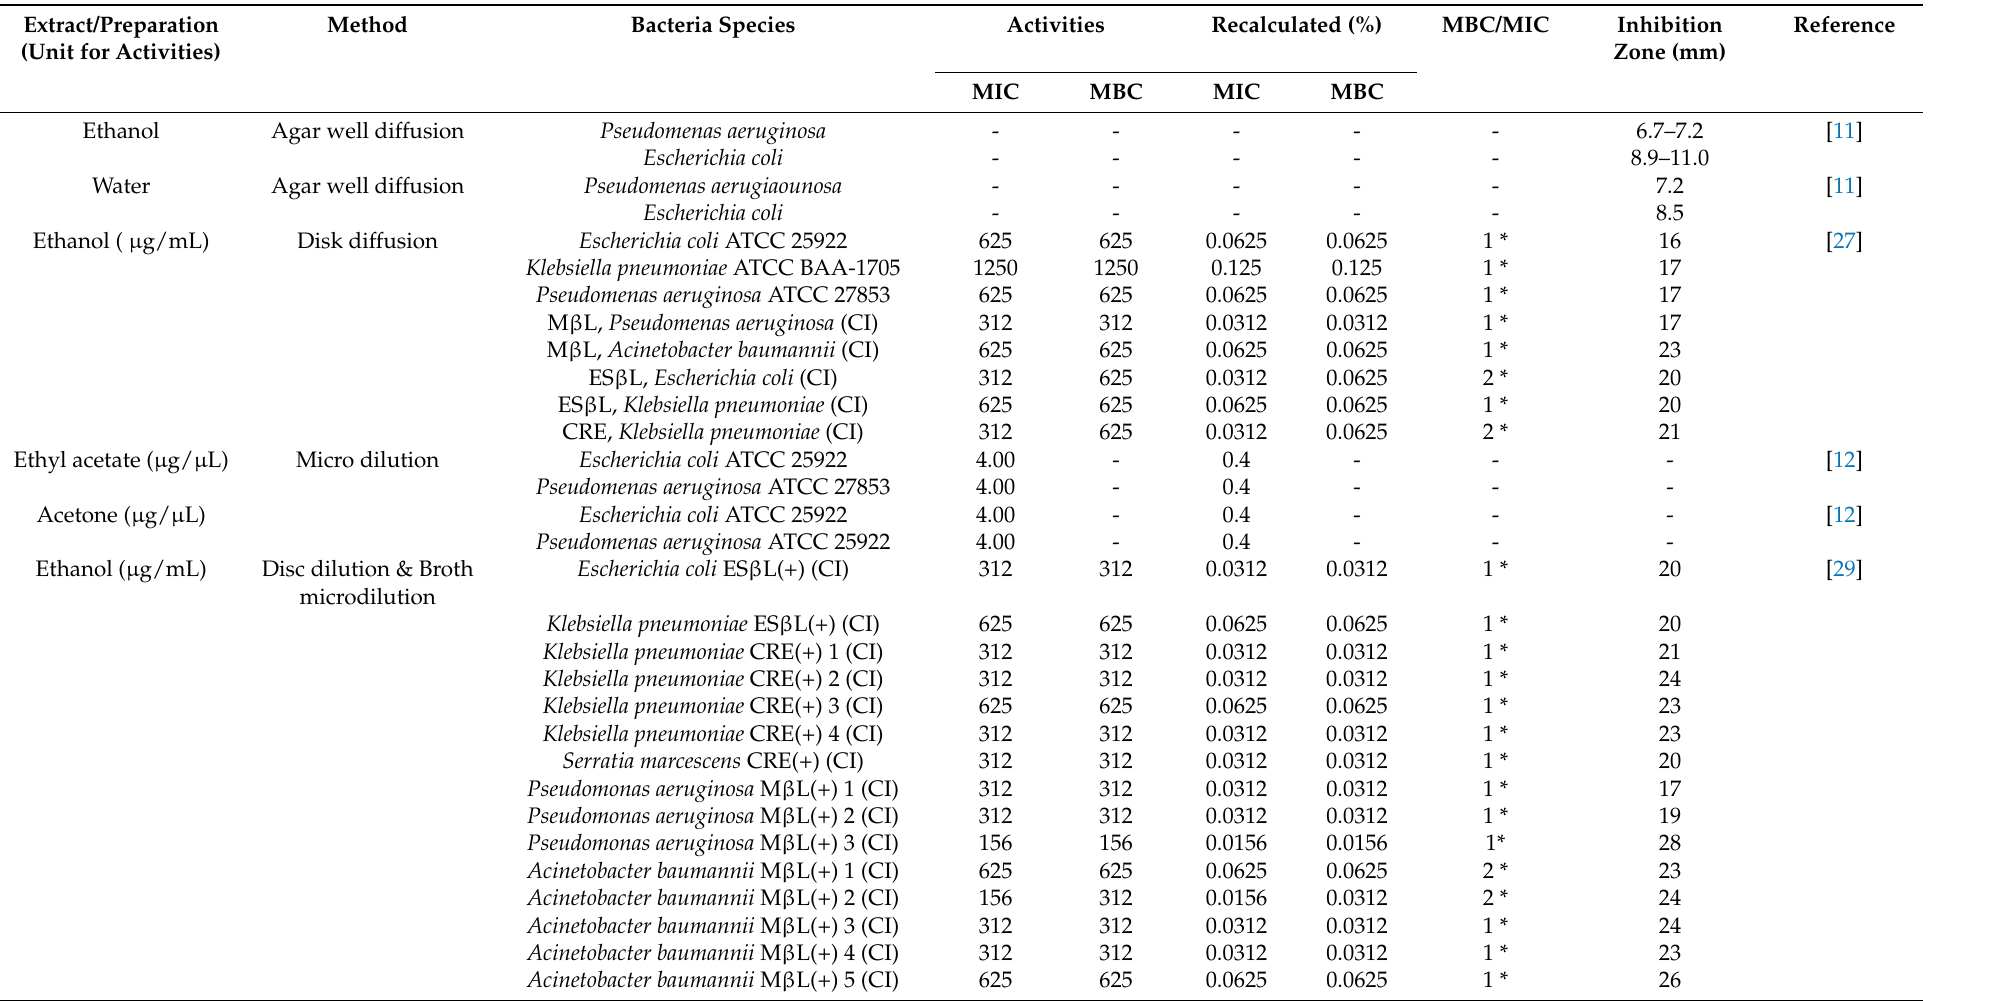
Table 2. Piper betle against Gram-negative